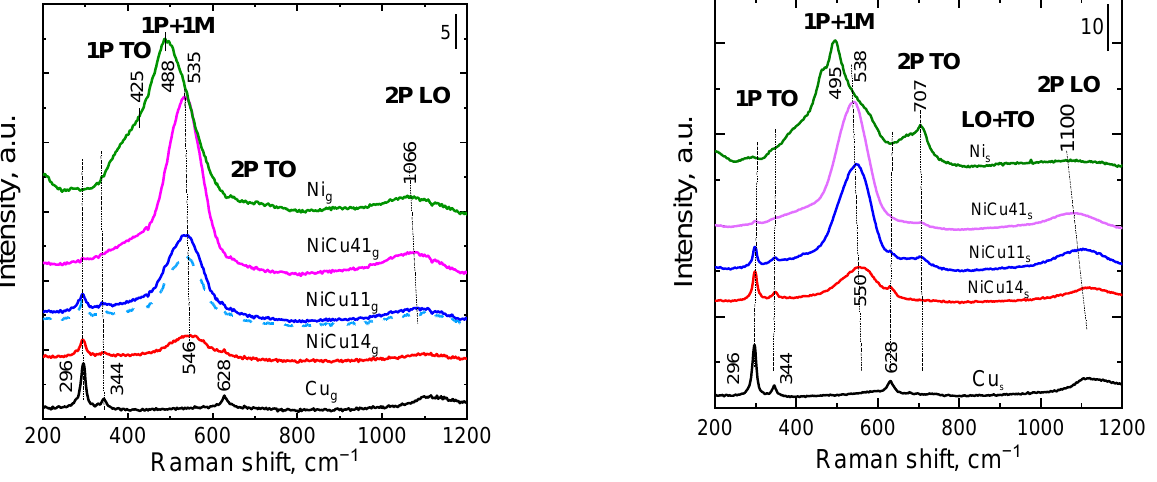
Figure 4. Raman spectra (λ = 532 nm) of the granular ( left ) and sputtered ( right ) Ni-Cu catalysts in dependence on Ni:Cu molar ratio. The dashed spectrum corresponds to the pelletized NiCu11 pel catalyst.